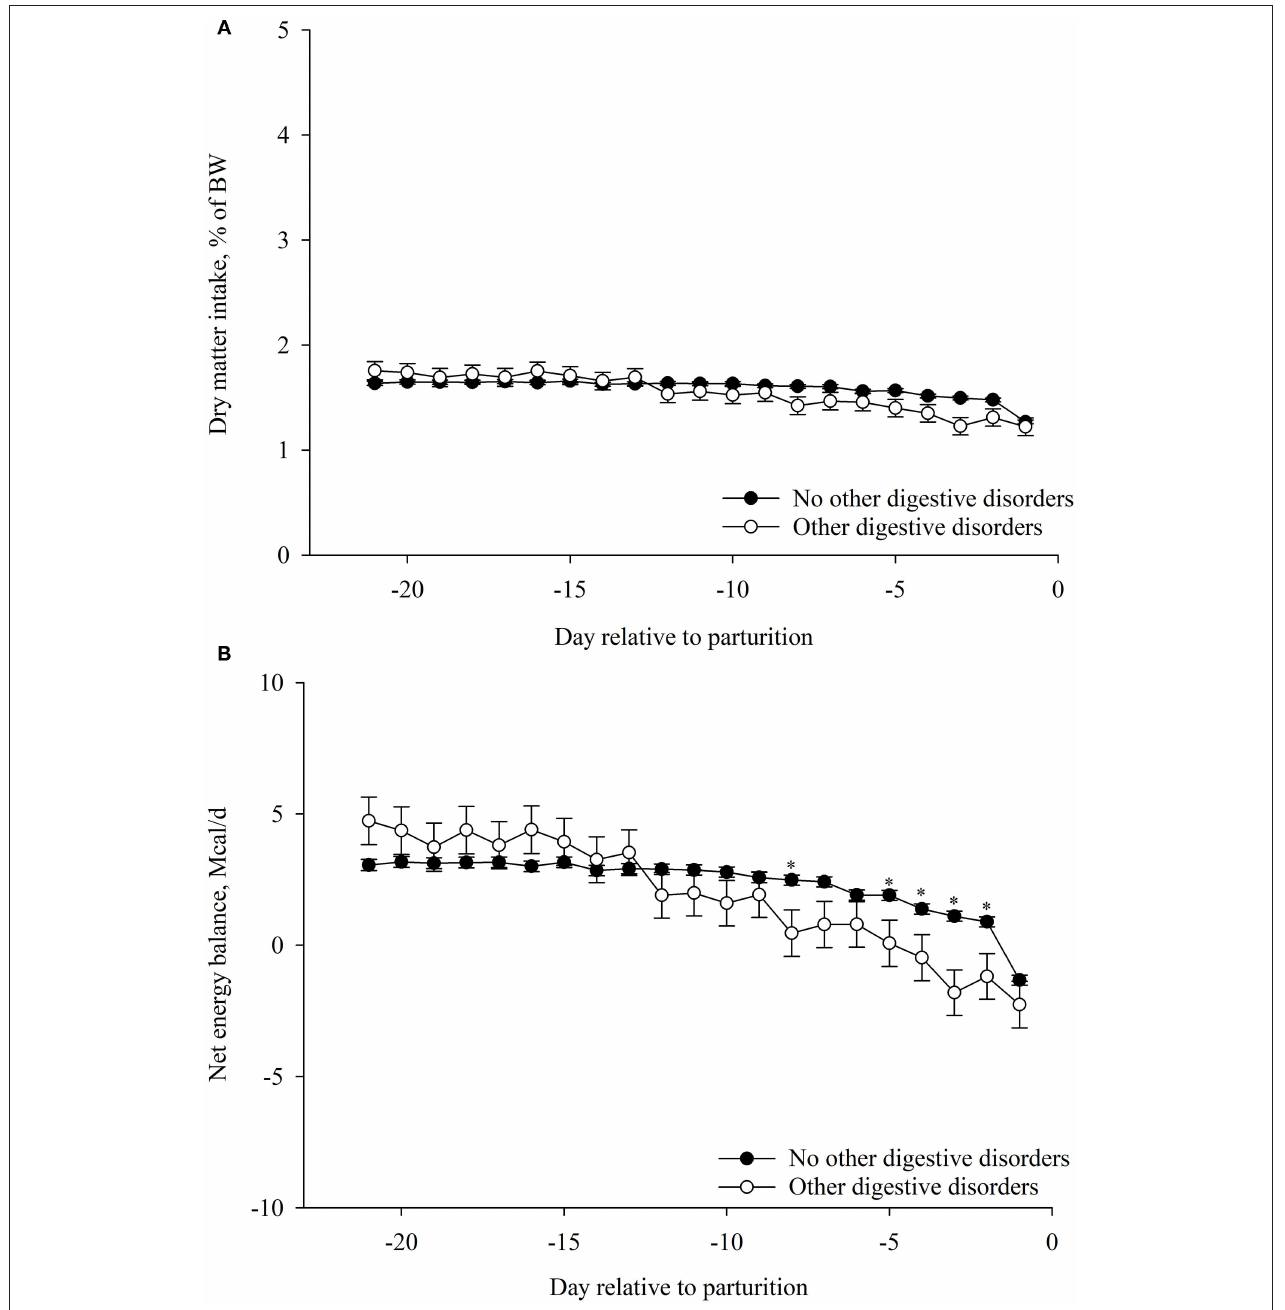
FIGURE 6 | Association of other digestive disorders postpartum ( n = 31) with (A) dry matter intake (DMI, %BW) and (B) net energy balance (EB, Mcal/day) during the prepartum period (from − 21 to − 1 day relative to parturition). Values are least square means ± SEM. Prepartum DMI (%BW): other digestive disorders, p = 0.51; day relative to parturition, p < 0.01; and the interaction between other digestive disorders and day, p < 0.01. Prepartum net energy balance: other digestive disorders, p = 0.53; day relative to parturition, p < 0.01; and the interaction between other digestive disorders and day, p < 0.01. * p ≤